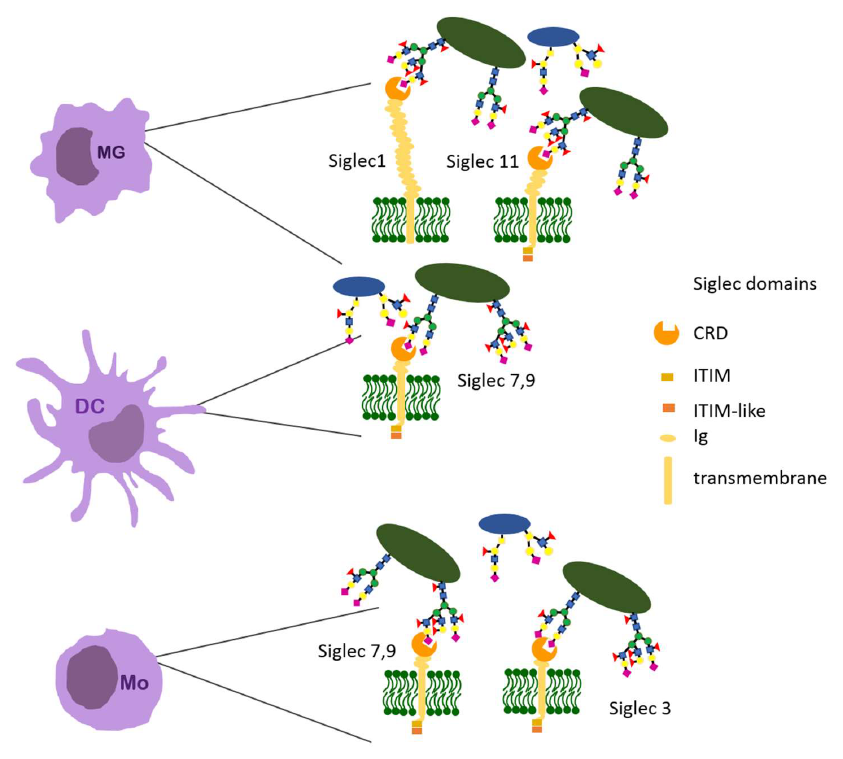
Figure 6. Examples of the siglecs presented on immune cells and their glycan ligands.